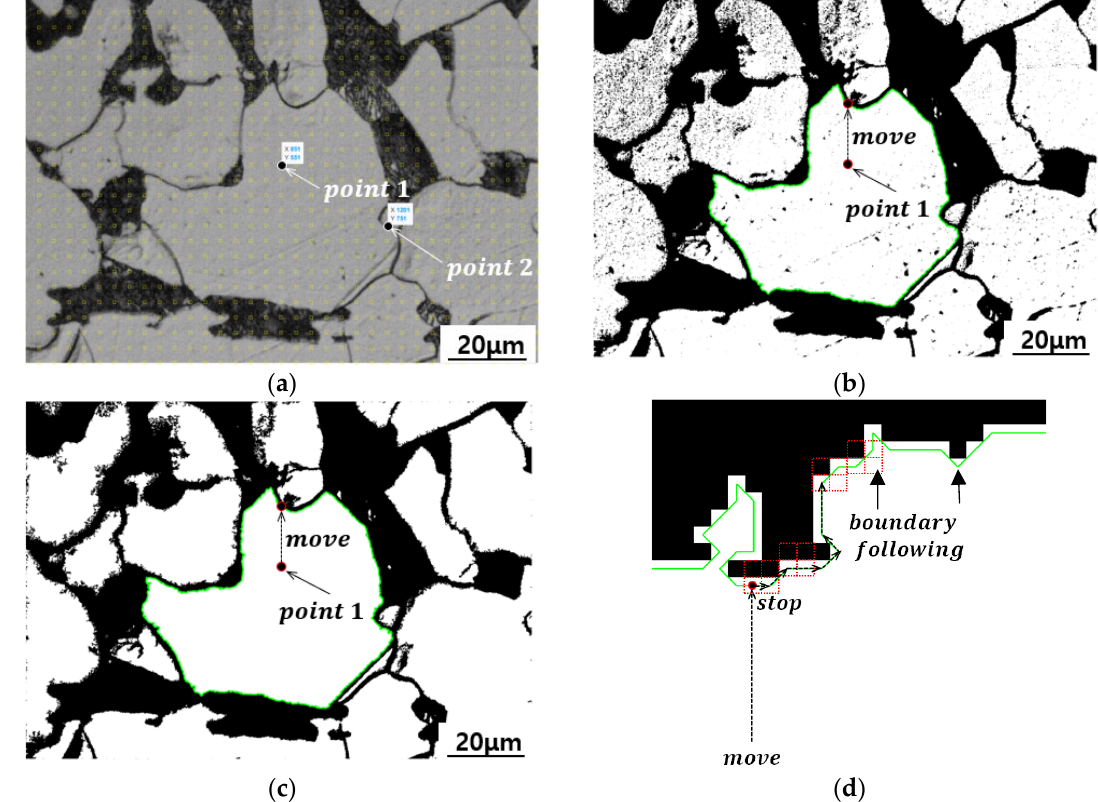
Figure 5. Algorithms for selection, binarization, and boundary extraction. ( a ) Select a structure and background; ( b ) Boundary extraction with voids; ( c ) Boundary extraction without voids; and ( d ) Boundary extraction algorithm.